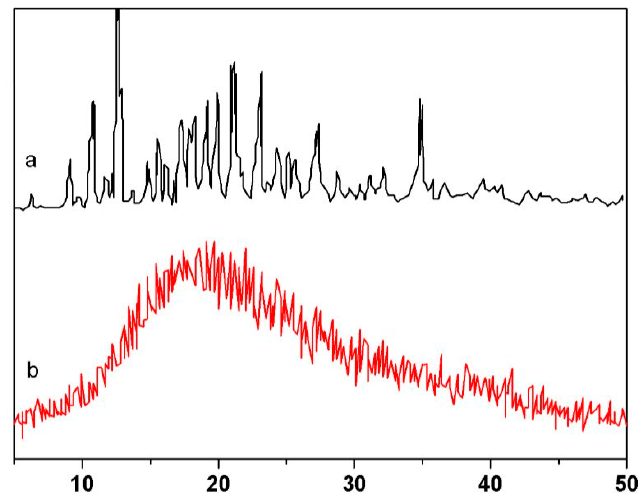
Figure 3. XRD pattern of β -CD ( a ) and β -CD(AN- co -AA) ( b ).